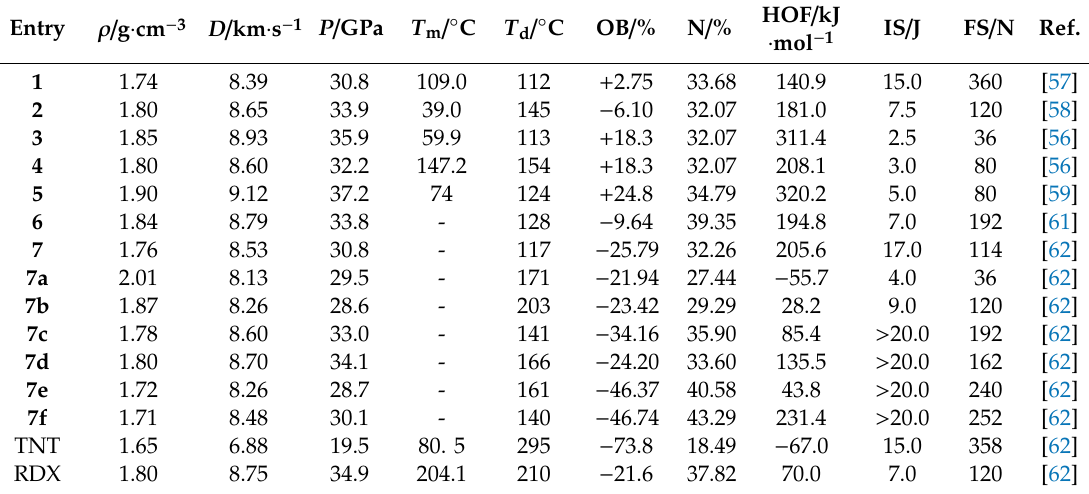
Table 2. Properties of the derivatives of compounds 1 – 7